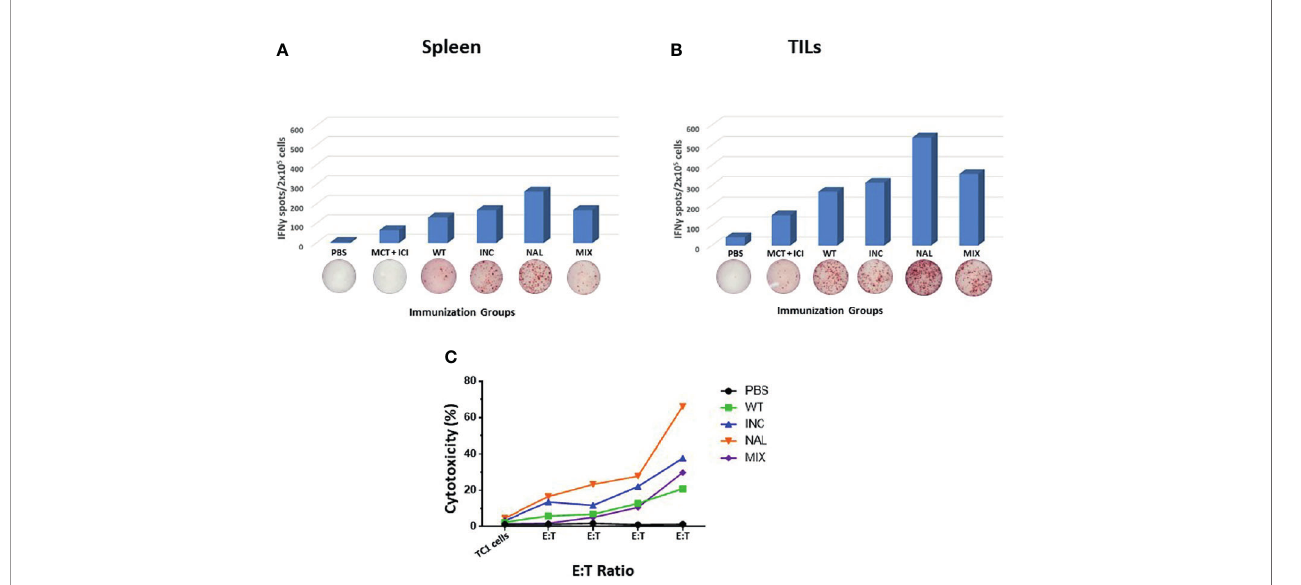
FIGURE 3 | Immune correlates in the therapeutic experimental model. Spleens (A) and TILs (B) from sacri fi ced animals in each HPV-E7 immunization groups were evaluated in an IFN g EliSpot assay after re-challenge with wt epitope. (C) Cytotoxicity assay was assessed using TC1 cells as target cells at the indicated target: effector (T:E) ratios. Each peptide immunization was performed with the MCT + ICI